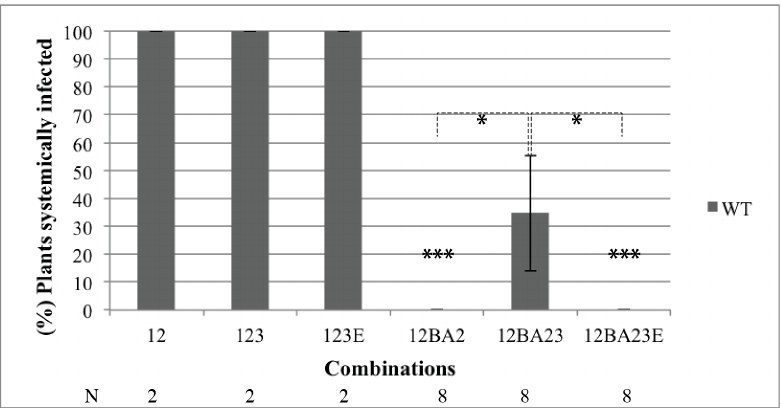
Figure 3. The BNYVV ncRNA3 contributes to systemic movement of the BA2 mutant of the BNYVV VSR. Wild ‐ type (WT) Nicotiana benthamiana were infected with RNA1 + 2 (12) or RNA1 + 2BA2 (12BA2) supplemented or not with RNA3 (123, 12BA23) or RNA3E (123E, 12BA23E). Viral RNA detection on upper leaves was performed at 21 dpi. Three independent experiments using specified numbers (N) of plants were performed, and statistical analyses were carried out using Fisher’s exact test. The p ‐ values were obtained from the false discovery rate method. * p ‐ value < 0.05 and *** p ‐ value < 0.001.